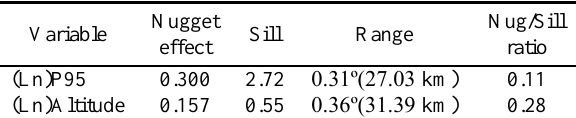
Table 2 . Parameters for onmidirectional semi-variograms Variable